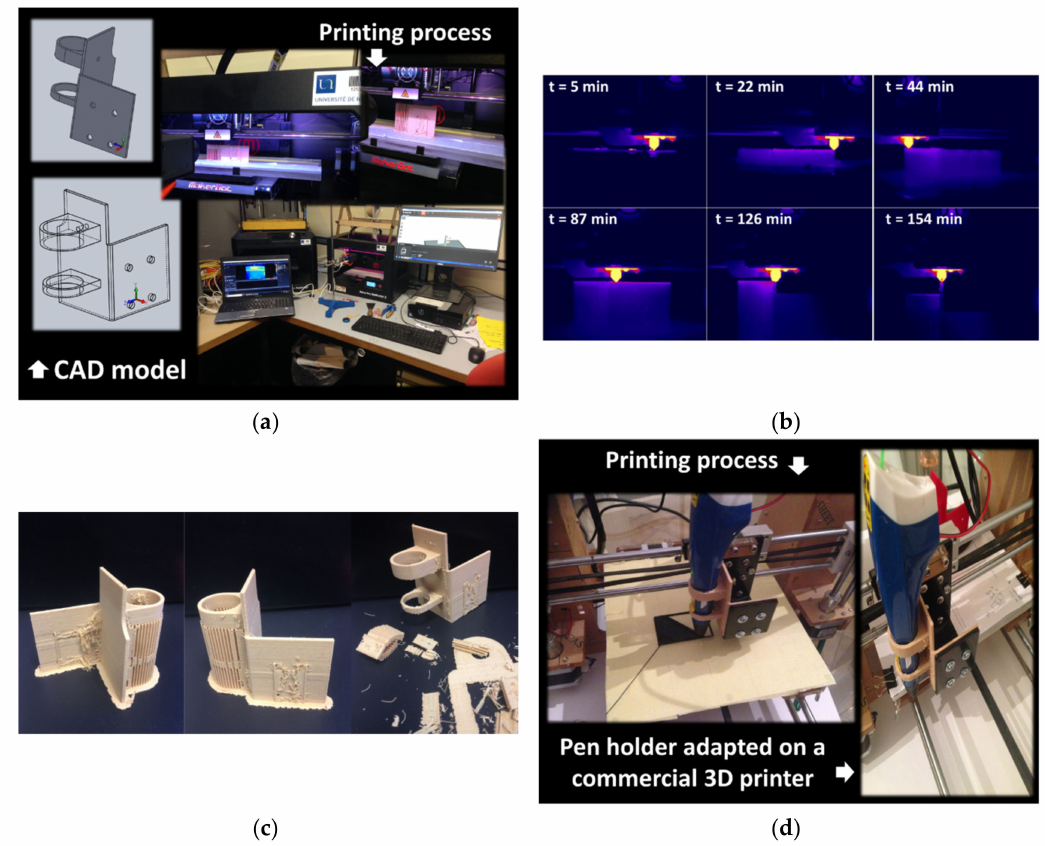
Figure 12. ( a ) Mains steps for designing a 3D printing pen holder on a commercial printer, ( b ) infra-red monitoring during the laying down process, ( c ) final rendering of the part prior to and after support removal, ( d ) part fixation and performance during